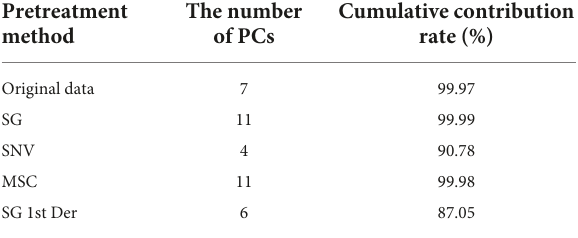
TABLE 3 Summary of data dimension reduction by PCA under different pretreatment methods.